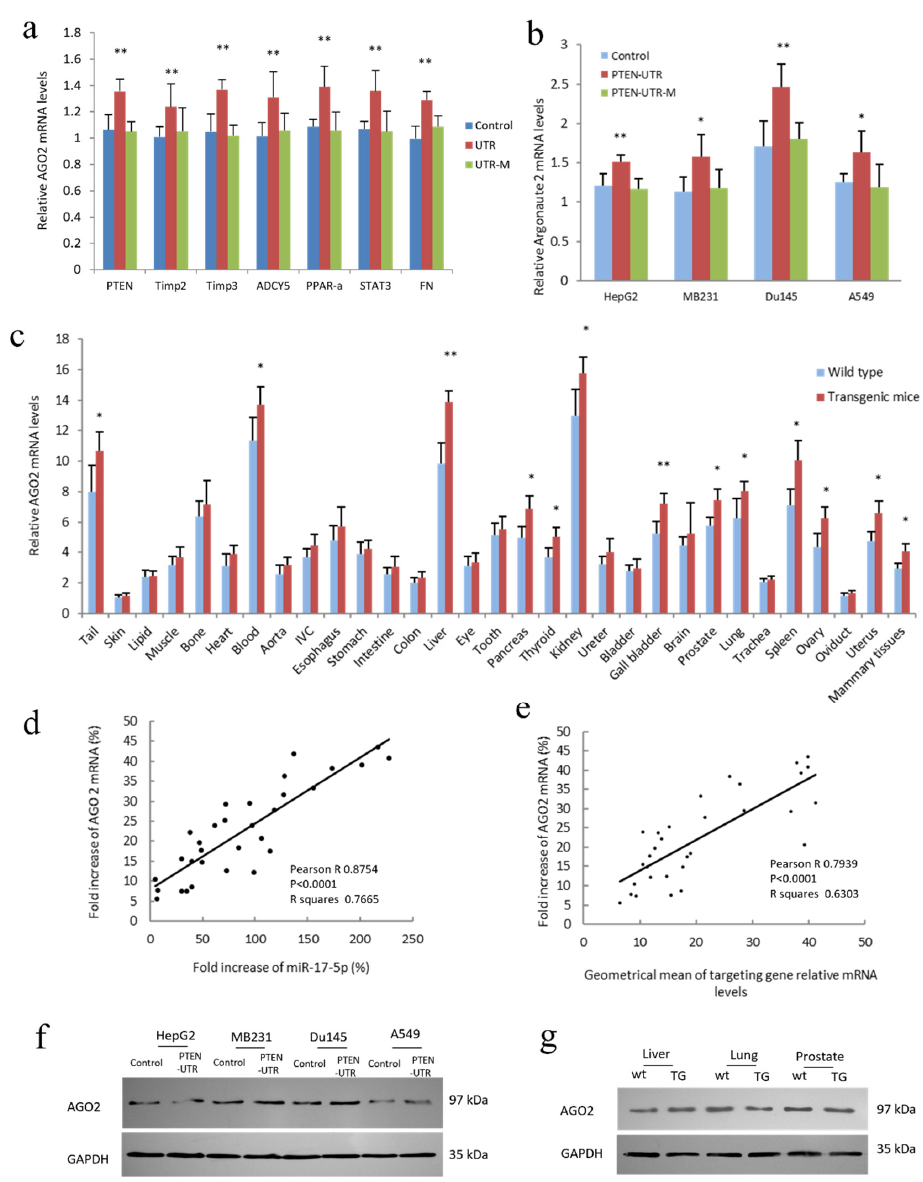
Figure 4. AGO2 mRNA increased in PTEN-UTR transfected cancer cell lines and miR-17-5p transgenic mice. ( a ) HepG2 cells were co-transfected with miR-17-5p and a control vector, 3 ′ UTR or 3 ′ UTR-M of PTEN, Timp2, Timp3, ADCY5, PPAR- α , STAT3, and FN. 3 ′ UTR transfected cells showed increased AGO2 mRNA levels. ** p < 0.01 vs. control; Error bars, SD; n = 5. ( b ) miR-17-5p and a control vector, PTEN-UTR or PTEN-UTR-M were co-transfected to HepG2, MDA-MB-231, DU145, and A549 cell lines. Expression of PTEN-UTR increased miR-17-5p levels in these cell lines. * p < 0.05, ** p < 0.01 vs. control; Error bars, SD; n = 5. ( c ) miR-17-5p transgenic mice expressed in- creased AGO2 mRNA levels compared to WT mice. Expression varies among organs. * p < 0.05, ** p < 0.01 vs. WT; Error bars, SD; n = 4. ( d ) Pearson correlation between fold increases of AGO2 mRNA and miR-17-5p in organs was analyzed by Prism 8. Fold increases in AGO2 mRNA were positively correlated with miR-17-5p. Pearson R = 0.8754; p < 0.0001; n = 31. ( e ) Pearson correlation between fold increases of AGO2 mRNA and geometrical mean of 12 cancer-related miR-17-5p target mRNAs in organs was analyzed by Prism 8. The fold increase of AGO2 mRNA was positively correlated with the geometrical mean of these 12 miR-17-5p target mRNAs. Pearson R = 0.7939; p < 0.0001; n = 31. ( f ) HepG2, MB231, Du145, and A549 cells were co-transfected with miR-17-5p and a control